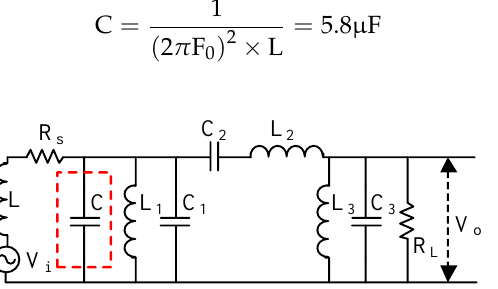
Figure 7. The circuit structure of the LC bandpass filter connecting a matching capacitor.